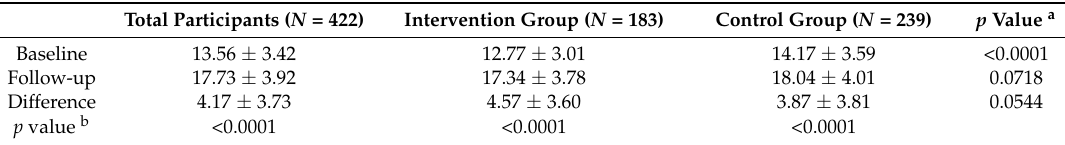
Table 3. Comparison of changes in serum 25(OH)D before and after the intervention among school-children (ng/mL). Total Participants ( N = 422) Intervention Group ( N = 183)